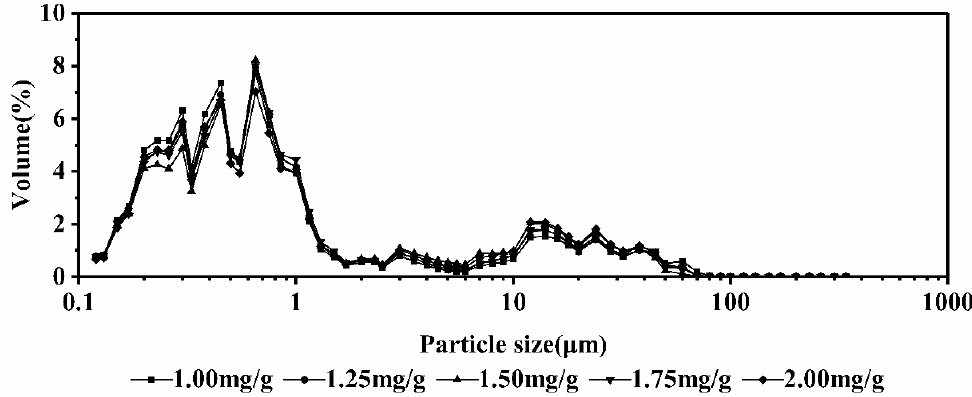
Figure 6. The particle size distribution of different concentrations of milk calcium-fortified milk systems at 95 °C.